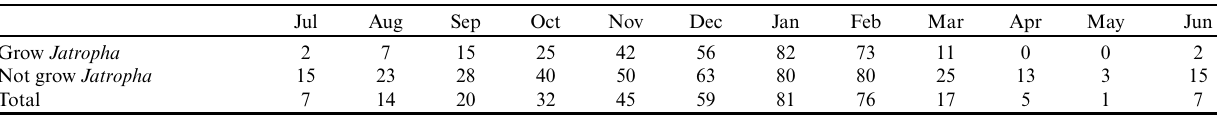
Table 8. Households in Malawi reporting hunger each month (% of households).